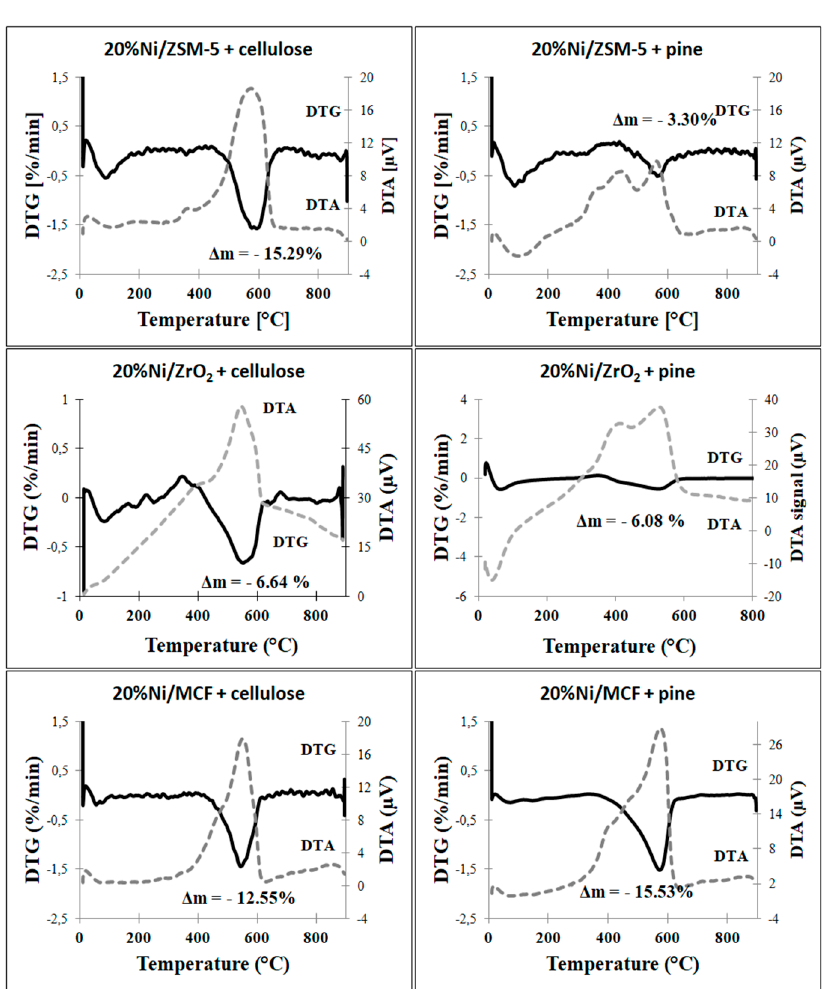
Figure 6. TGA-DTA curves of the catalysts.